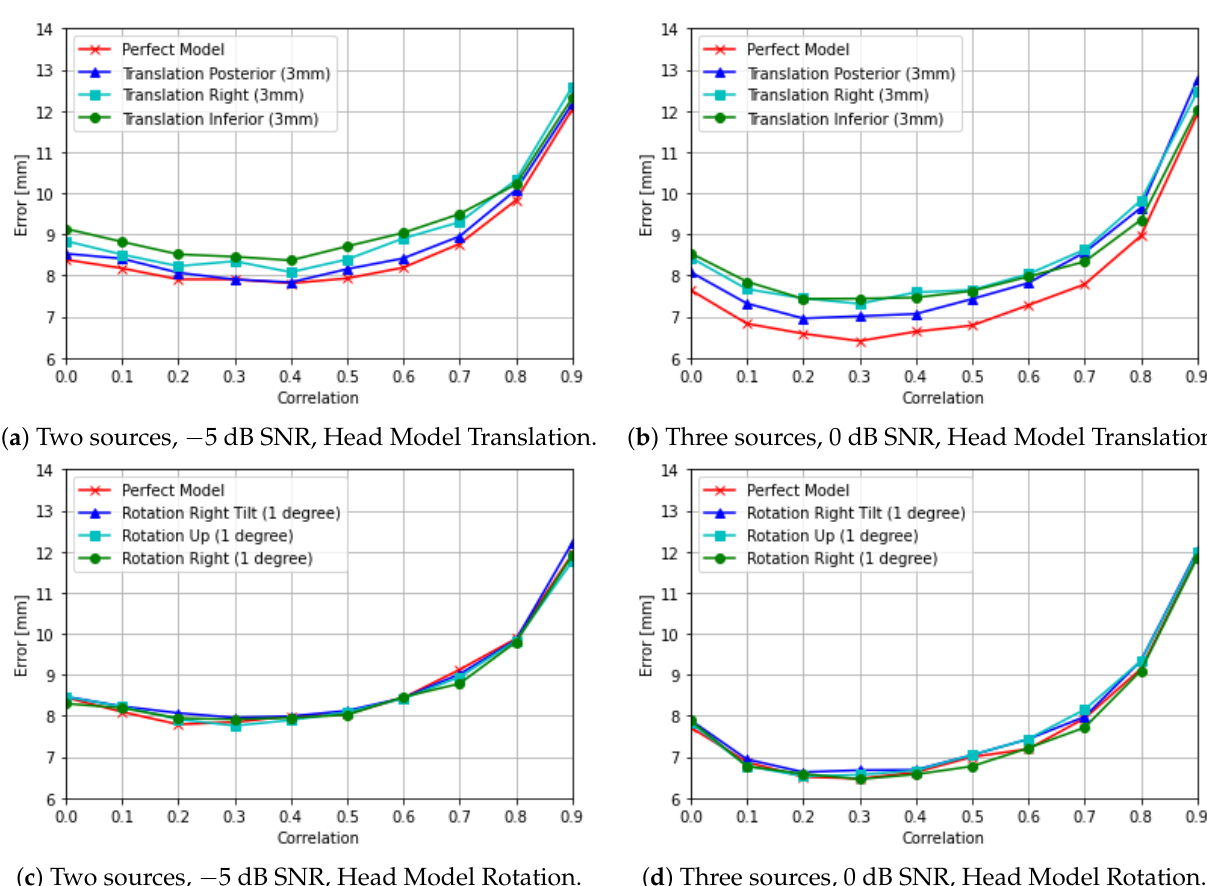
Figure 7. Robustness of DeepMEG-CNN localization accuracy to forward model errors due to head model translations by 3 mm ( a , b ), and head model rotations by 1 degree ( c , d